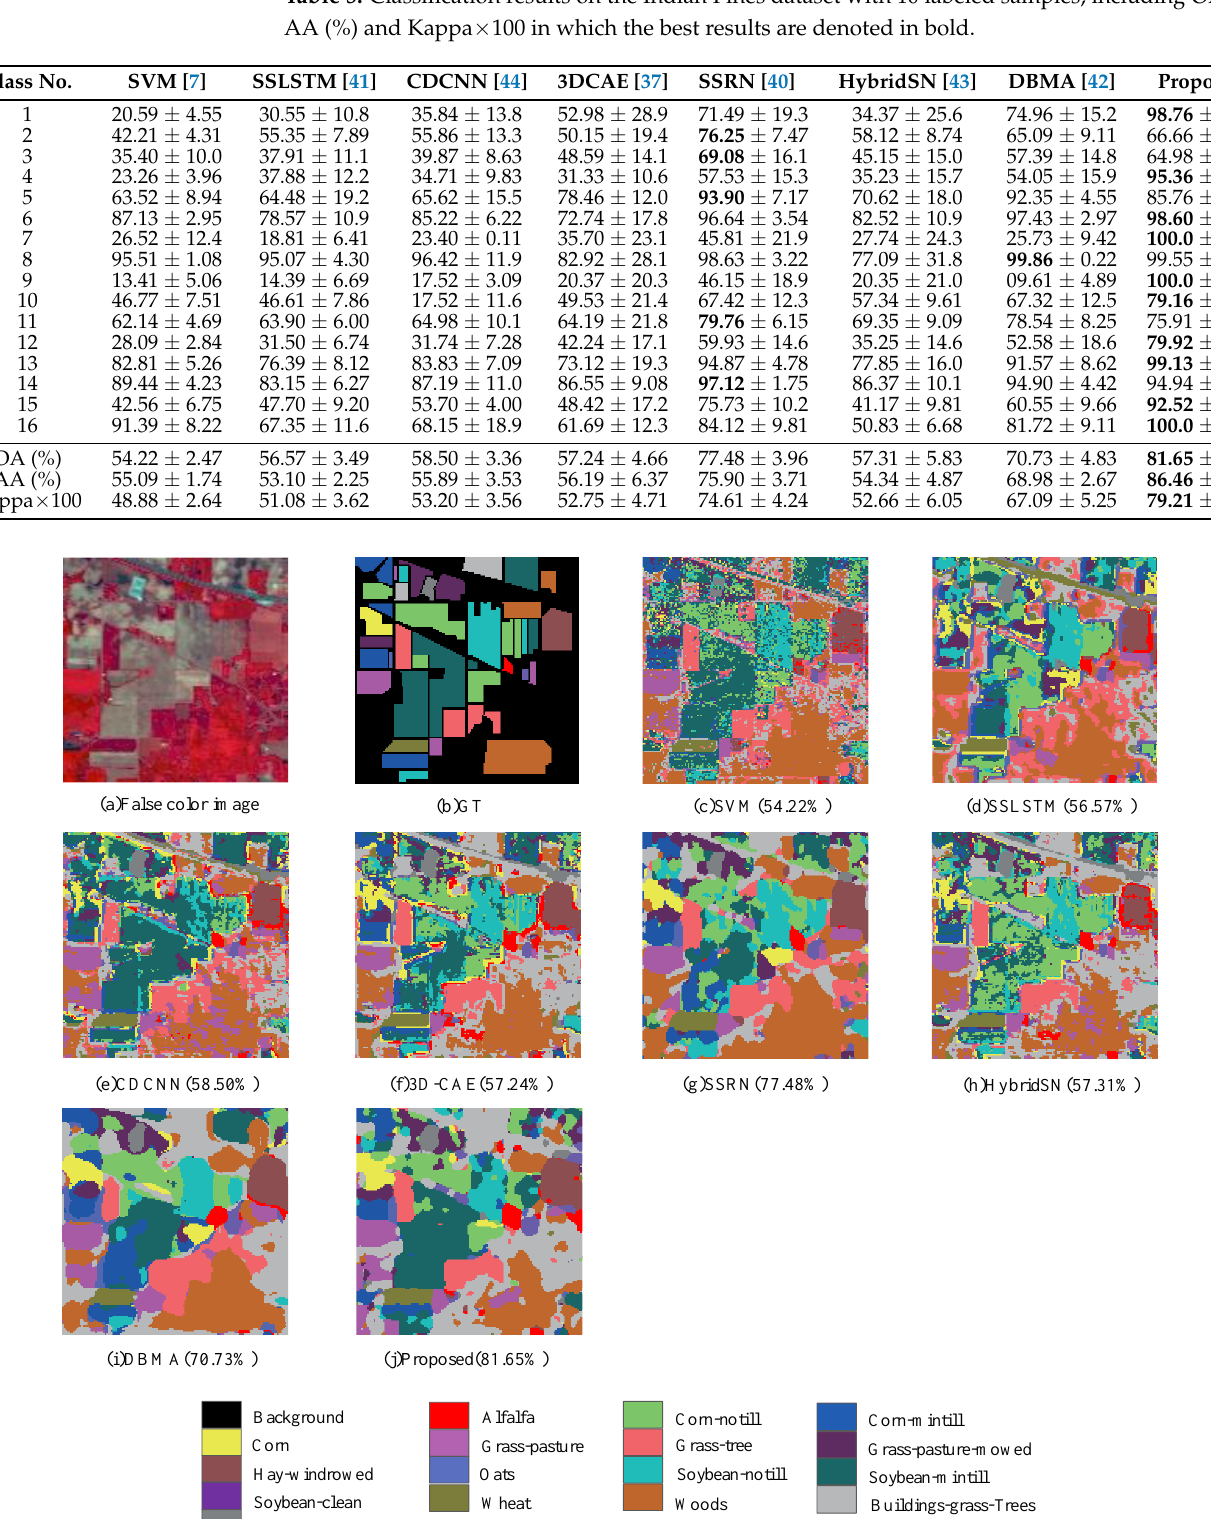
Figure 4. The classification maps of the Indian Pines with 10 labeled